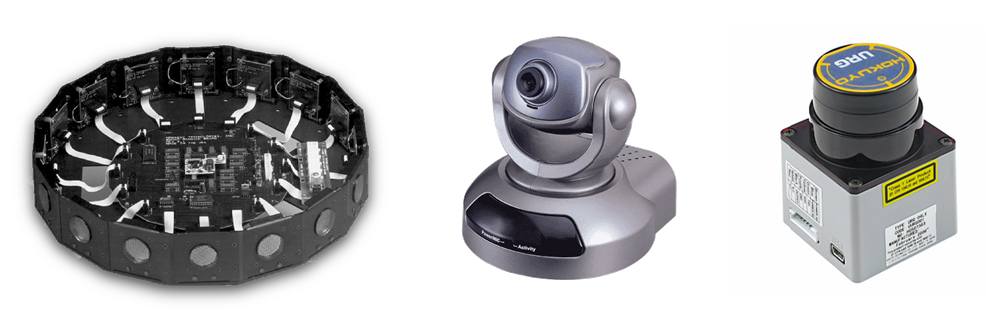
Sonar ring of sensors widely used for indoor mobile robots (left), Vivotek wireless pan-tilt camera (center), and Hokuyo URG-04LX laser range-finder typically used in robotics for navigation and localization